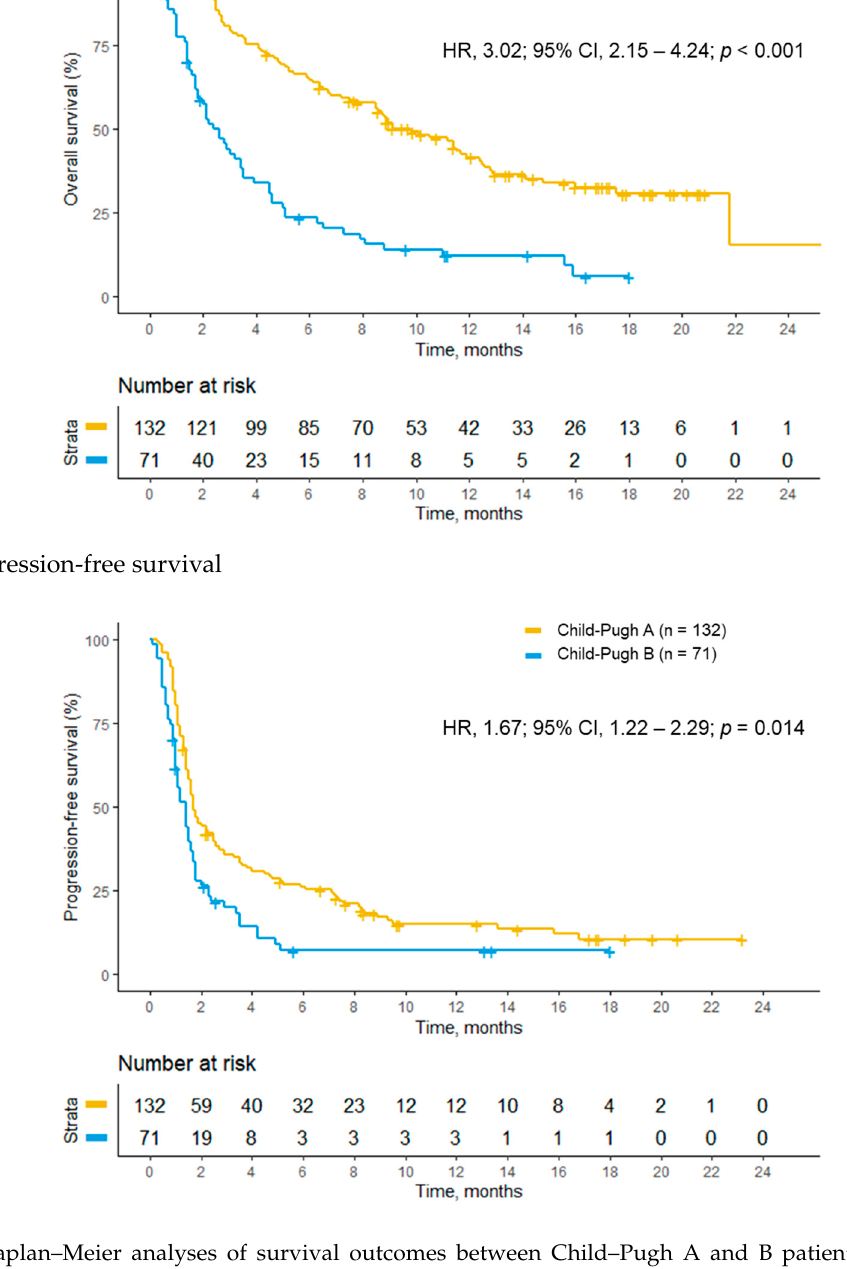
Figure 1. Kaplan–Meier analyses of survival outcomes between Child–Pugh A and B patients. ( A ) overall survival and ( B ) progression-free survival.